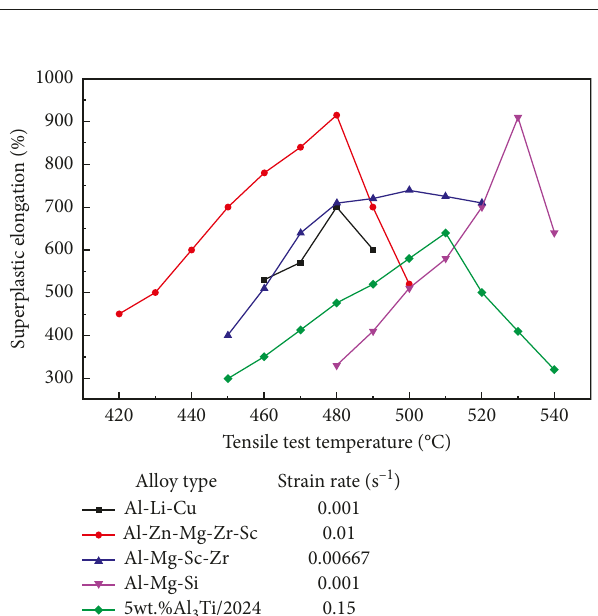
Figure 5: Variation of superplastic elongations of different Al alloys with initial strain rates at various